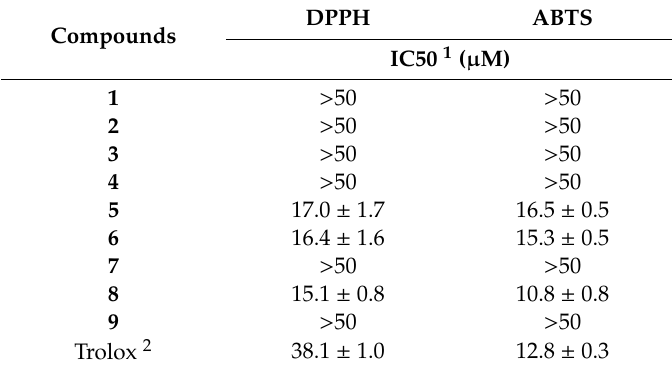
Table 3. E ff ect of isolated compounds on DPPH and ABTS free radical-scavenging activity. DPPH ABTS Compounds IC50 1 ( µ M) 1 > 50 > 50 2 > 50 >